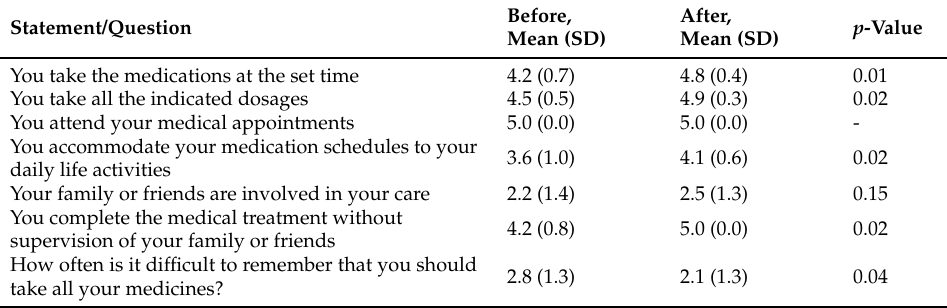
Table 6. Comparison between before and after using the virtual assistant.